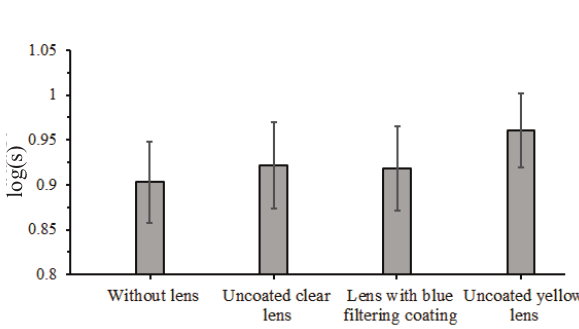
Fig. 3. Mean log(s) values of all participants measured without the lens in front of the eye, with the clear lens, with the blue- light-filtering lens, and with the yellow lens (the confidence interval [2 standard errors] is shown for each data series).